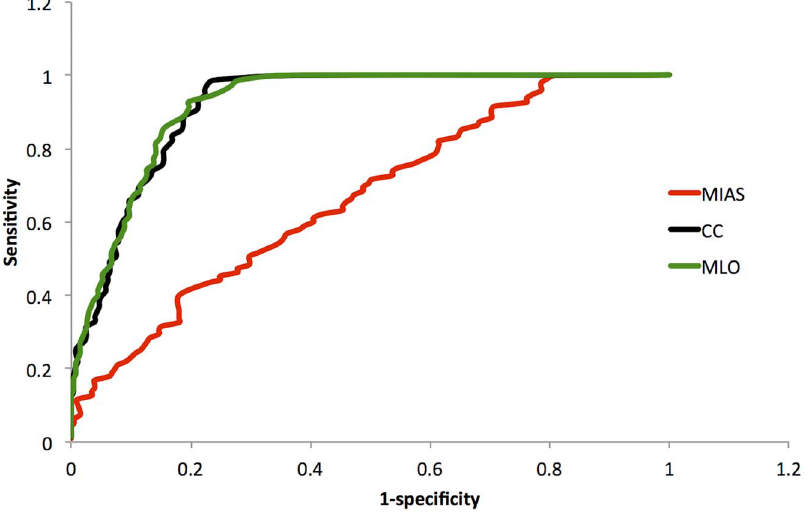
Figure 5. Bayesian three feature classifier performance. Sensitivity versus 1-specificity. The performance of the classifier was tested on MIAS (red), DDSM CC (blue and DDSM MLO (black) datasets. as was the case for one and two features the algorithm performed much better on the CC